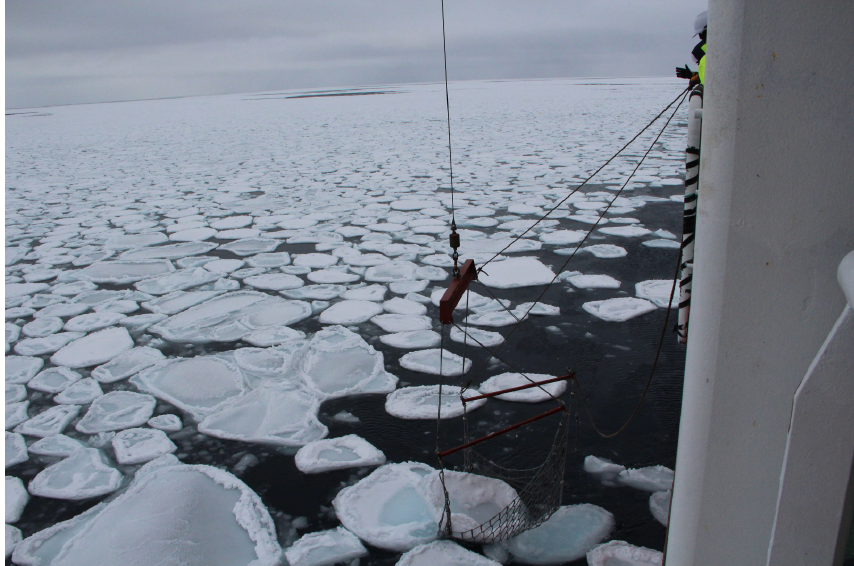
Figure 4. Sampling of solitary pancake ice floes with diameters of about 2.5m using the ship’s crane.